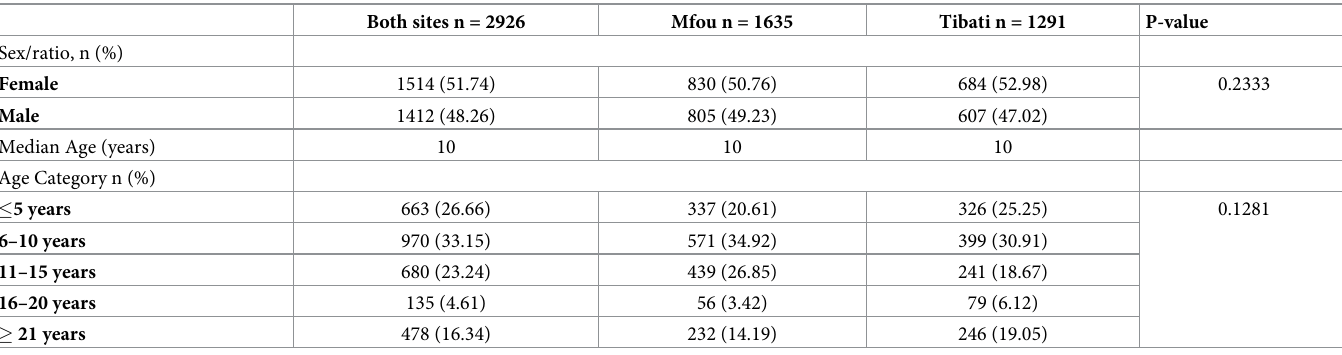
Table 2. Basic characteristics of population survey.